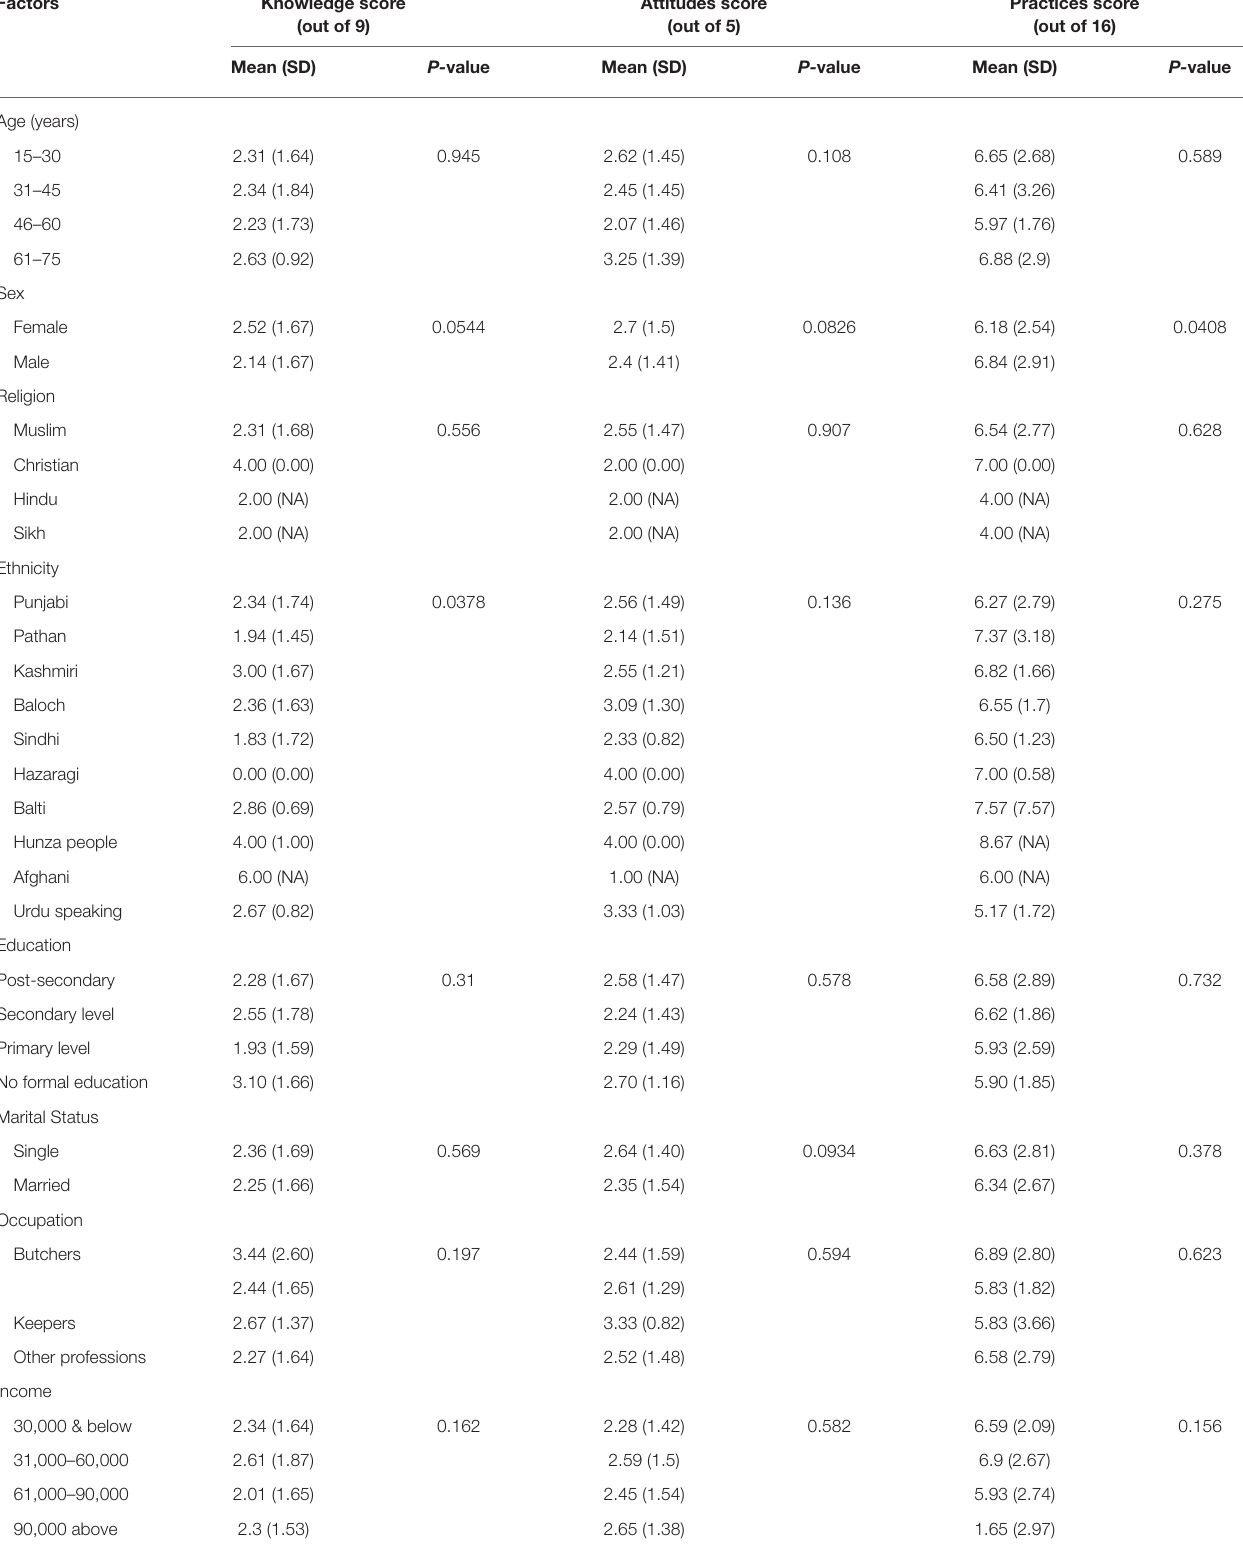
TABLE 9 | Statistical analysis of knowledge, attitude, and practices across different socio-demographic variables. Factors Knowledge score